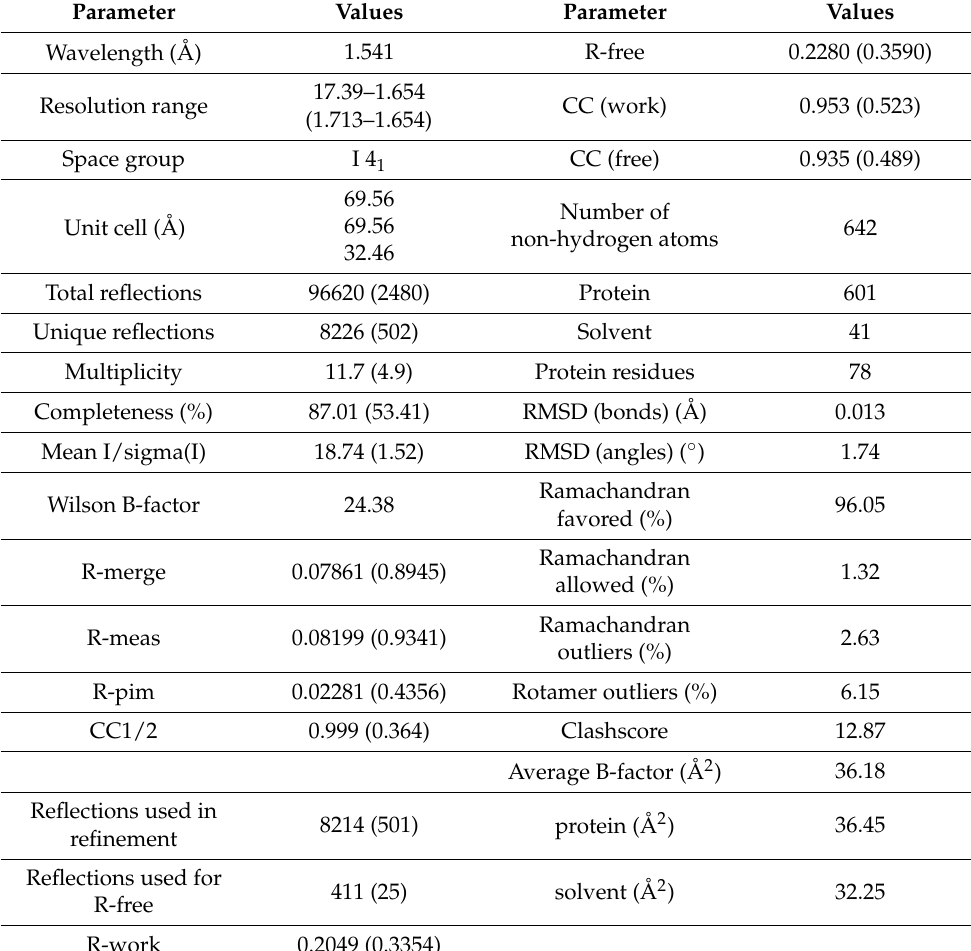
Table 1. Xray structure parameter of rAB-ELAV, Pdb code: 7QZP. Statistics for the highest-resolution shell are shown in